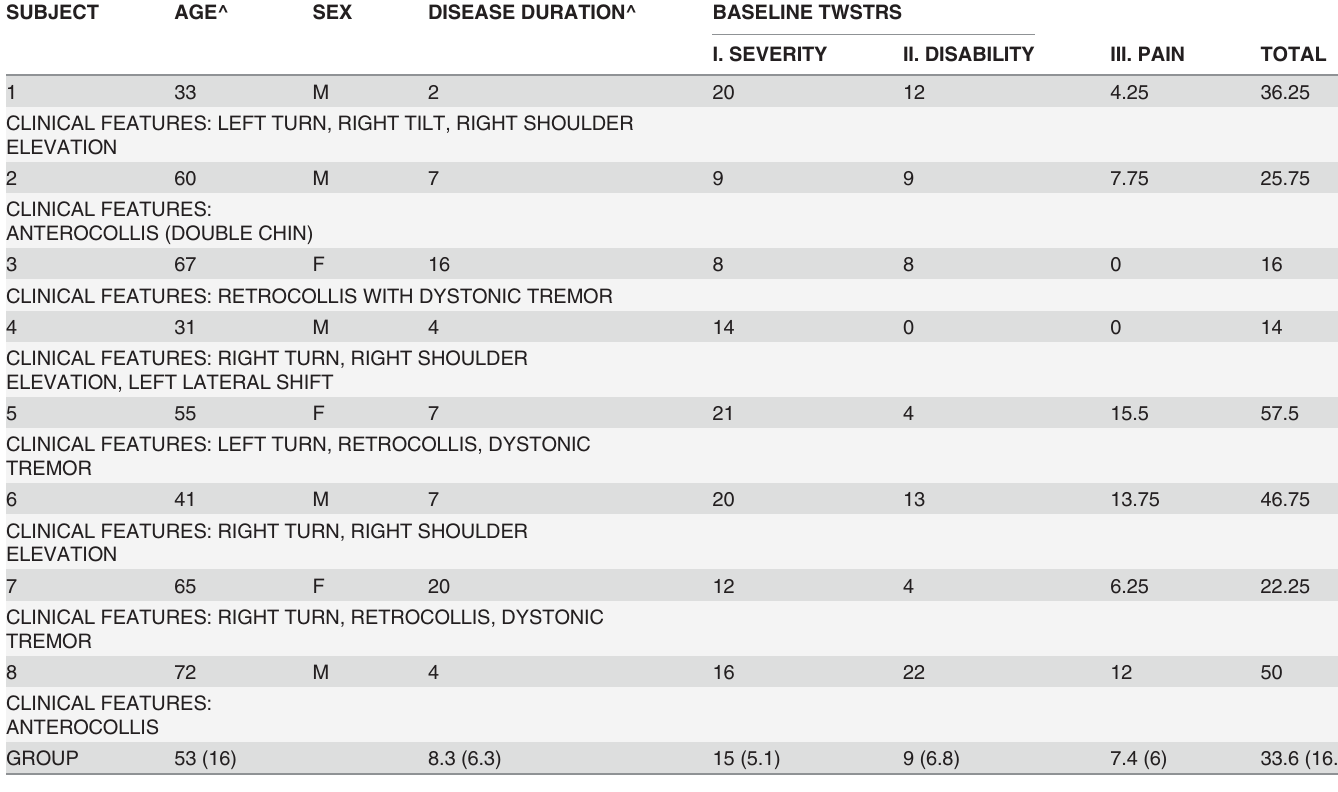
Table 1. Demographic, clinical features and baseline severity by participant and by